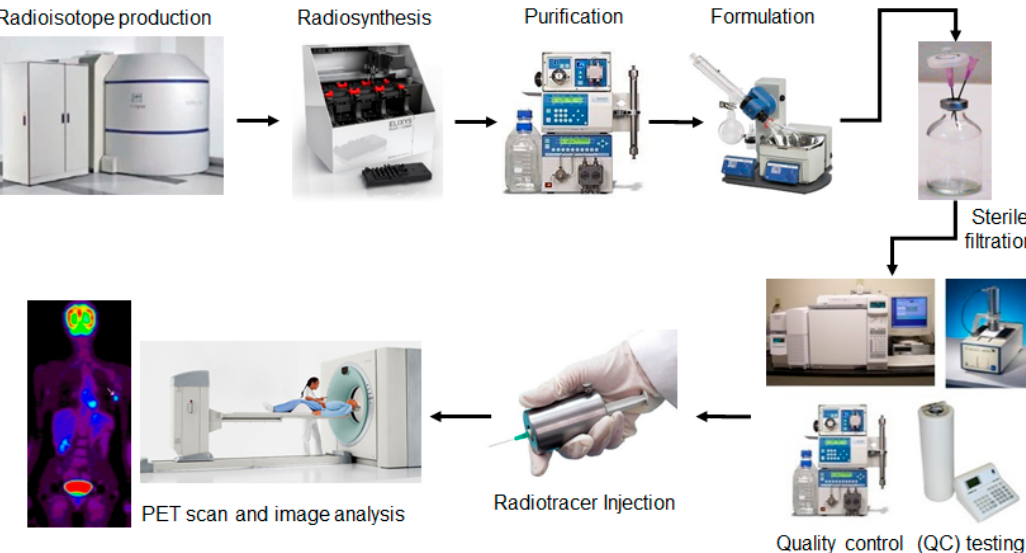
Figure 1. Production of positron emission tomography (PET)/single photon emission